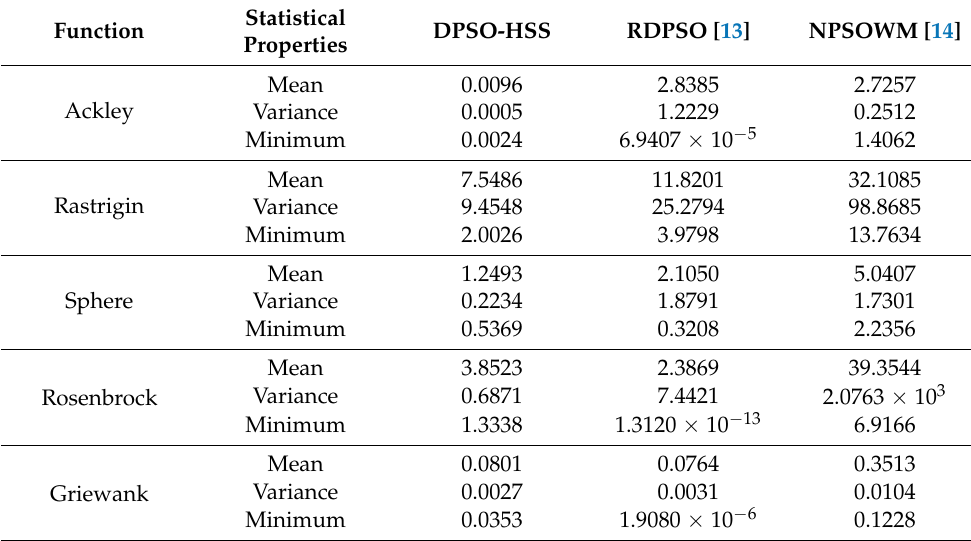
Table 2. Statistical properties of function tests using different